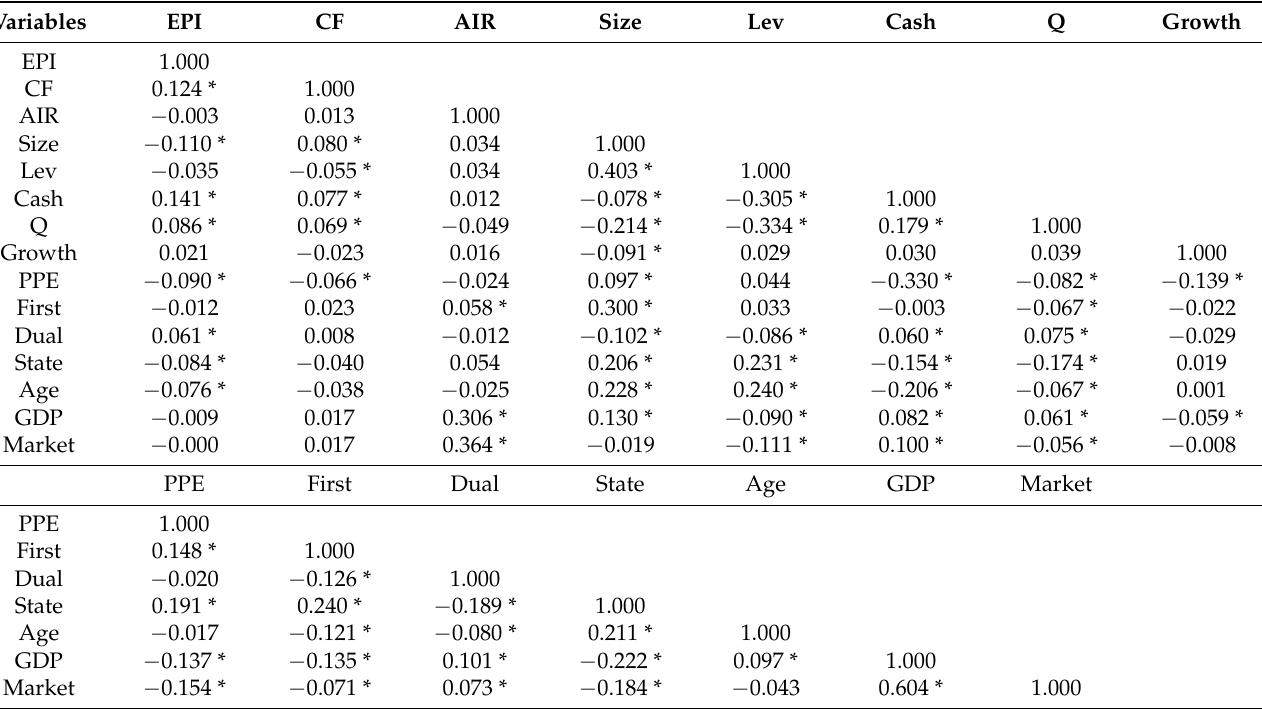
Table 4. Bivariate correlation analysis of main